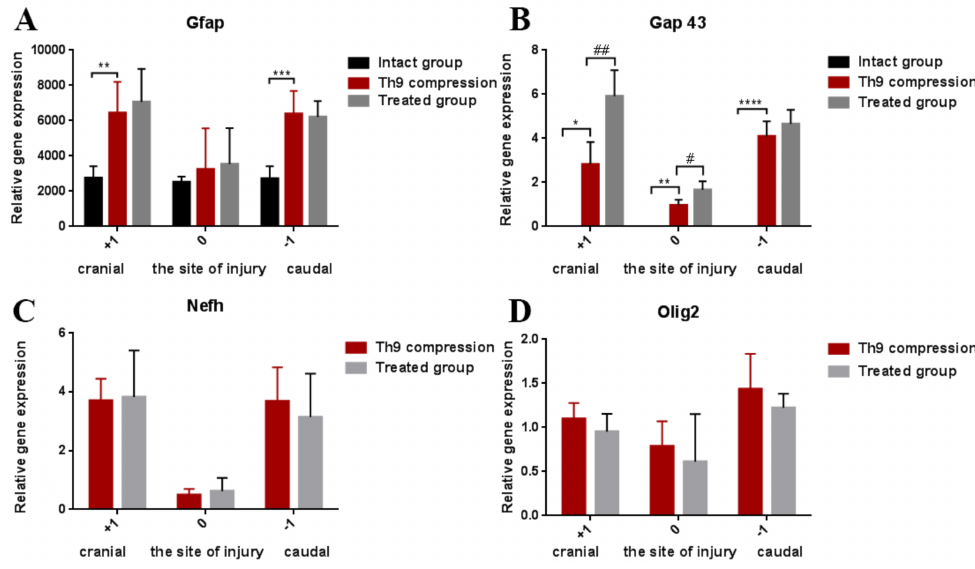
Figure 7. Graphs demonstrating the relative gene expression of GFAP, Gap 43, Nf-h, and Olig 2 in the spinal cord (site of the injury, cranially, and caudally) six weeks after the traumatic spinal cord injury and the ATR treatment. The lowest gene expression was observed at the lesion site. GFAP activation shows the changes in astrogliosis after the SCI and SCI + ATR ( A ). Markers of regenerative capacity (Gap 43, Nf-h, and Olig2) show a significant improvement in axonal outgrowing at the lesion site and in the cranial (+1) segment ( B – D ). The data are the mean values of five experiments ± SD. The results were statistically evaluated using a parametric T -test and one-way ANOVA; * p < 0.05; # p < 0.05; ** p < 0.01; ## p < 0.01; *** p < 0.001; **** p < 0.0001. Atorvastatin—ATR; Gap 43—outgrowing